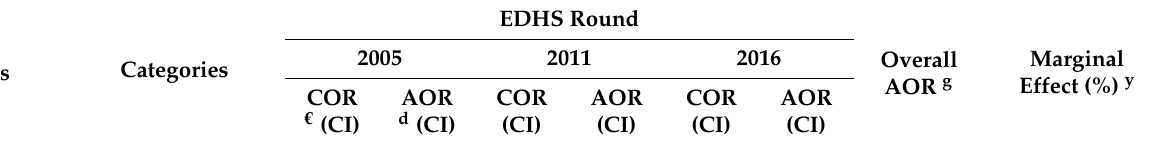
Table 3. Factors associated with an MDD, EDHS 2005 to 2016 (cid:51)